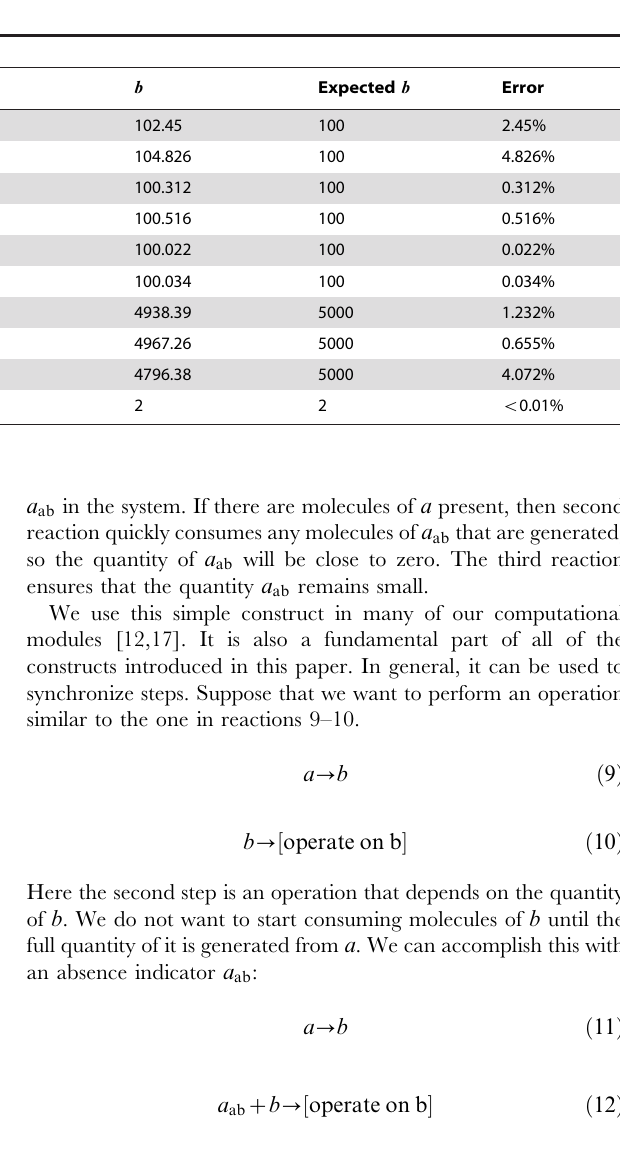
Table 3. Statistical simulation results for ‘‘Copier’’ construct.